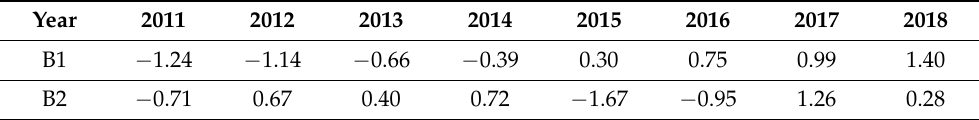
Table 4. The principal component scores in